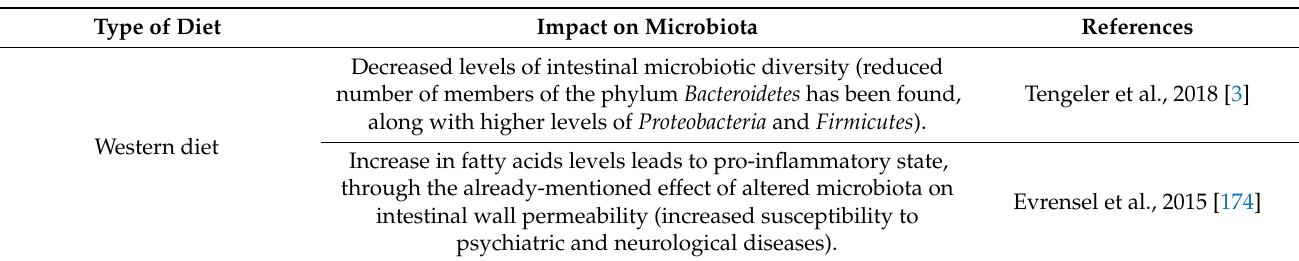
Table 1. The role of diet in microbiota